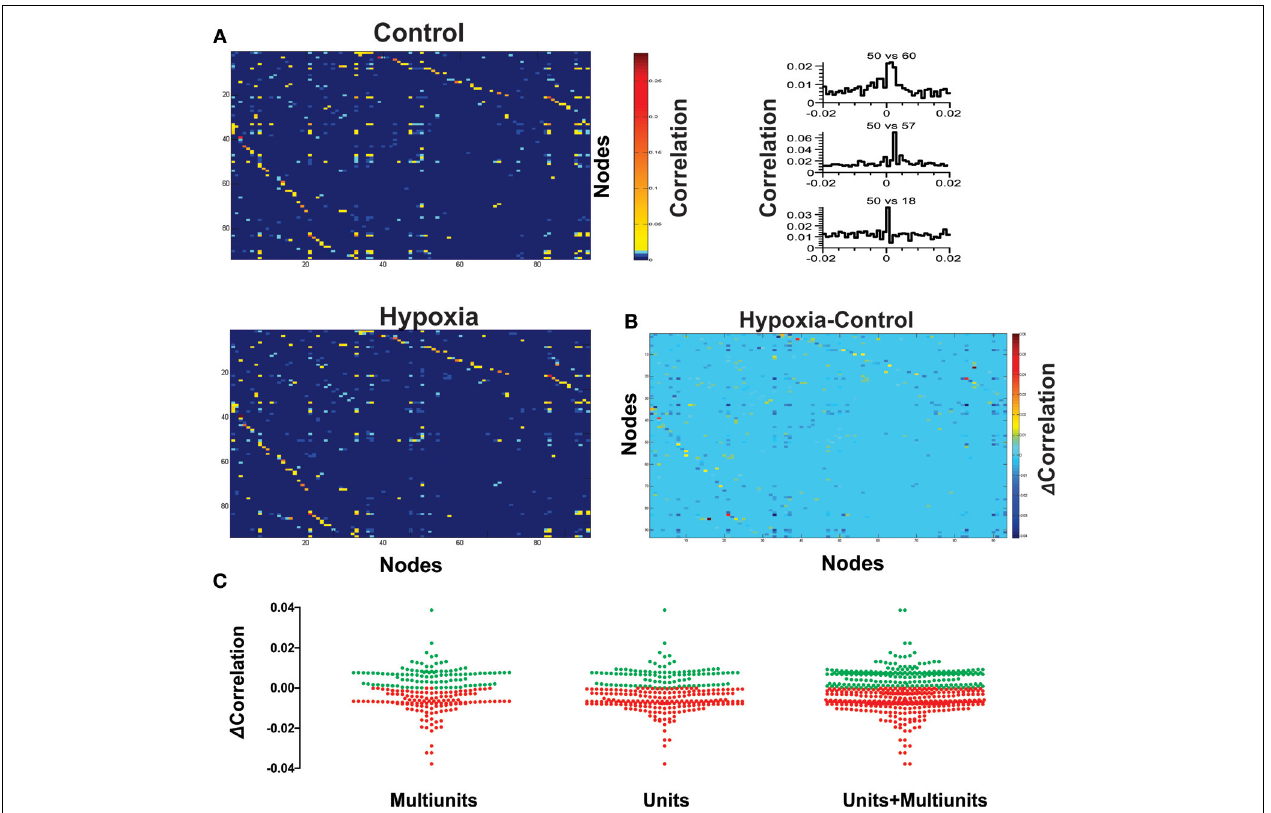
FIGURE 3 | Hypoxia reconfigures the functional interactions among the respiratory elements. (A) Examples of cross-correlograms of the activity recorded between elements are presented on the right. All significant pair-wise-possible correlations are represented as correlation matrices on the left for a representative slice in control and during hypoxic conditions; a pseudocolored scale indicates that different pairs are correlated to different extents. (B) Subtraction of correlation values of the matrices